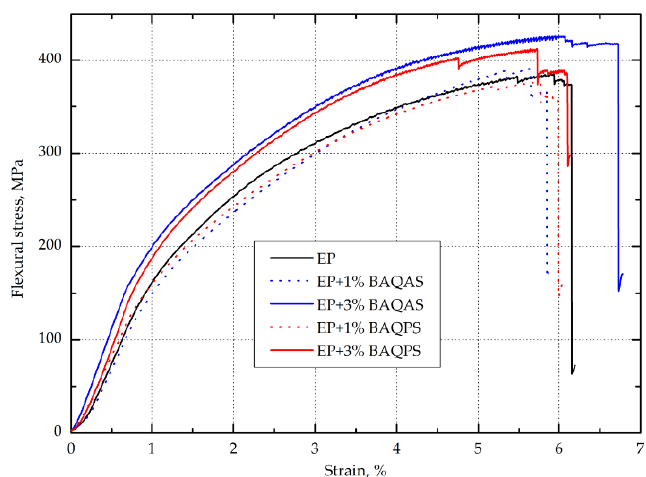
Figure 6. Representative stress-strain curves from the flexural test for the tested Kevlar-reinforced composites.